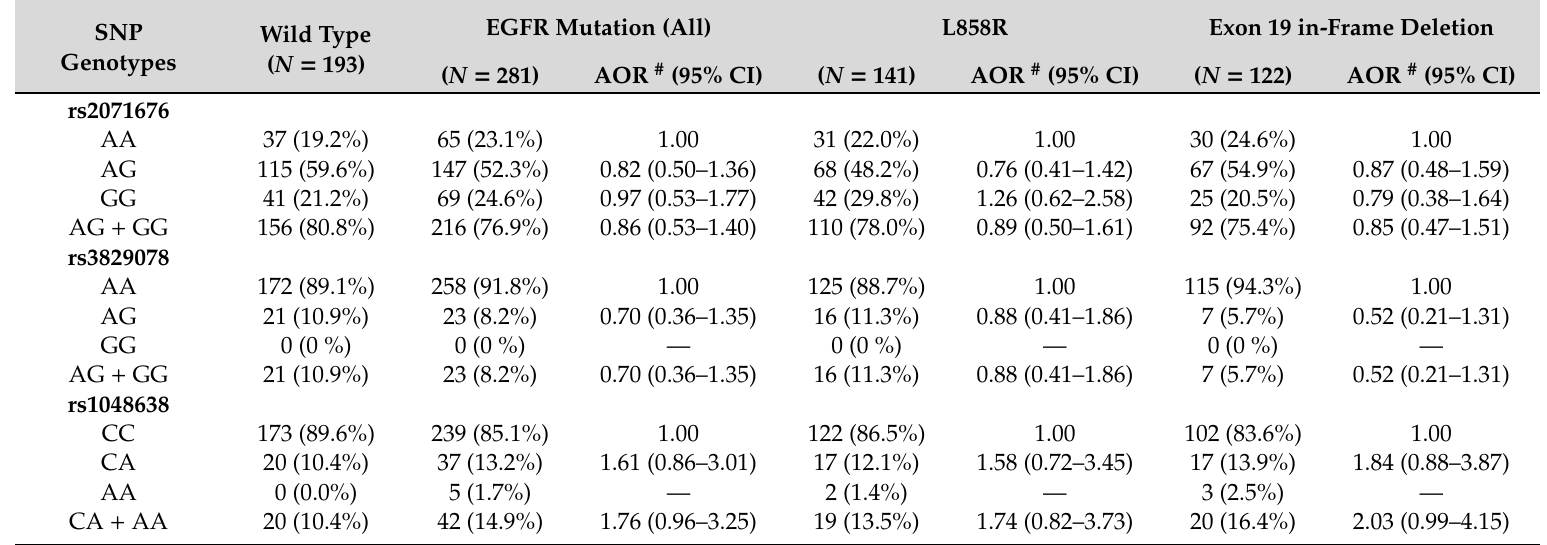
Table 2. Distribution frequency of carbonic anhydrase 9 genotypes of patients with lung adenocarcinoma and multiple logistic regression analysis of epidermal growth factor receptor mutation association.